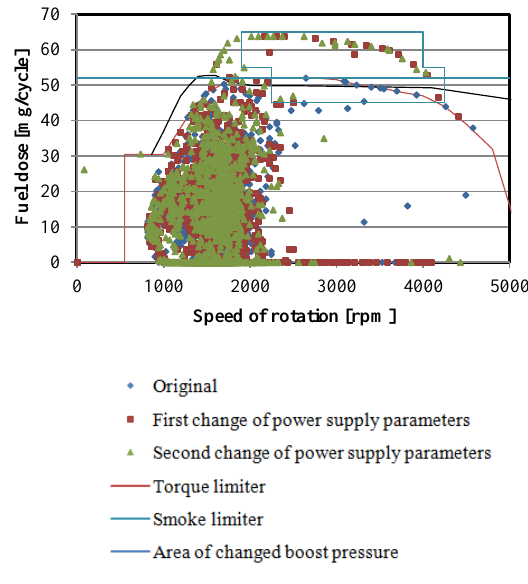
Fig. 8. Engine work points during car run